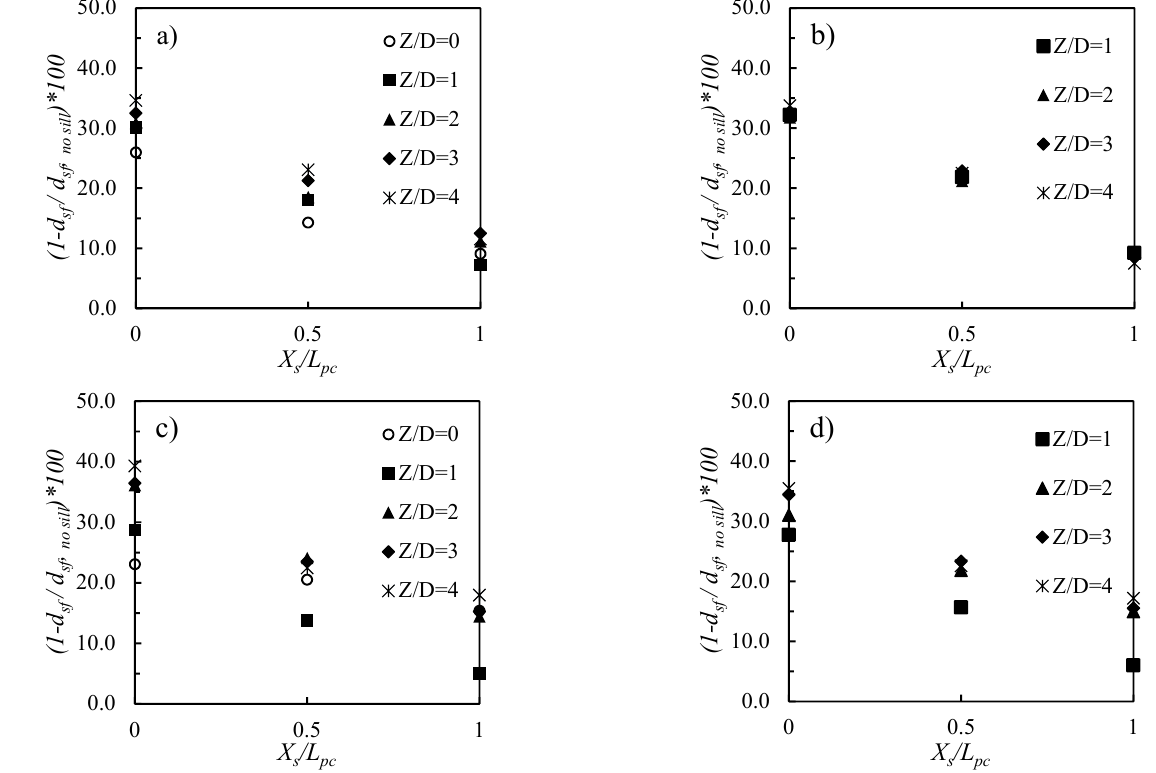
Figure 9. Comparison of maximum scour depth in conditions with and without sill for T pc / D = 0.85, d p /D = 0.85, ( a ) m = 2, ( b ) m = 3 and T pc /D = 1.42, d p /D = 0.85, ( c ) m = 2, ( d ) m = 3.